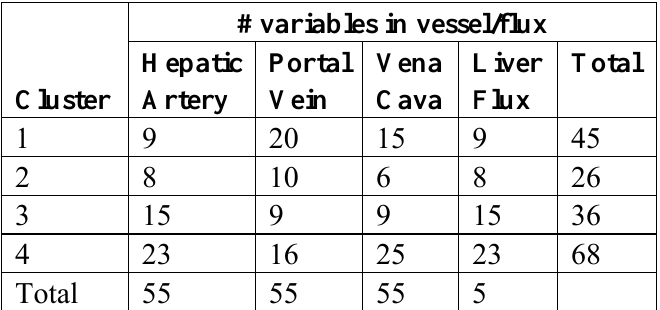
Table 2. Cluster membership as a function of vessel/flux.